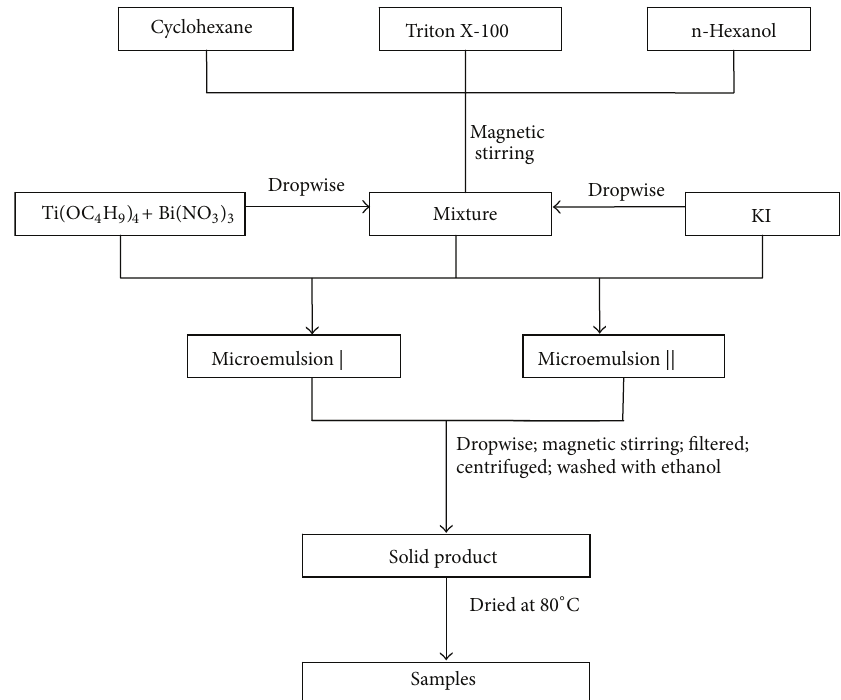
Figure 1: Flow chart of nanosized BiOI-TiO 2 particles synthesized by microemulsion.